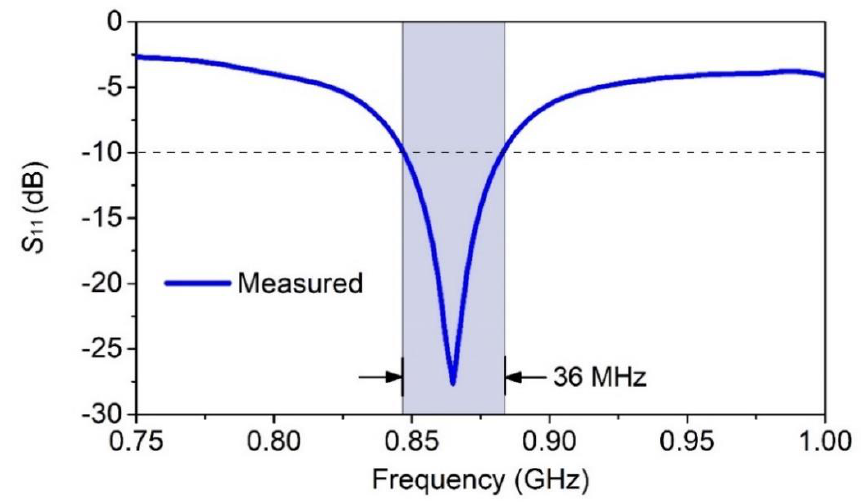
Figure 14. Measured S 11 response of the